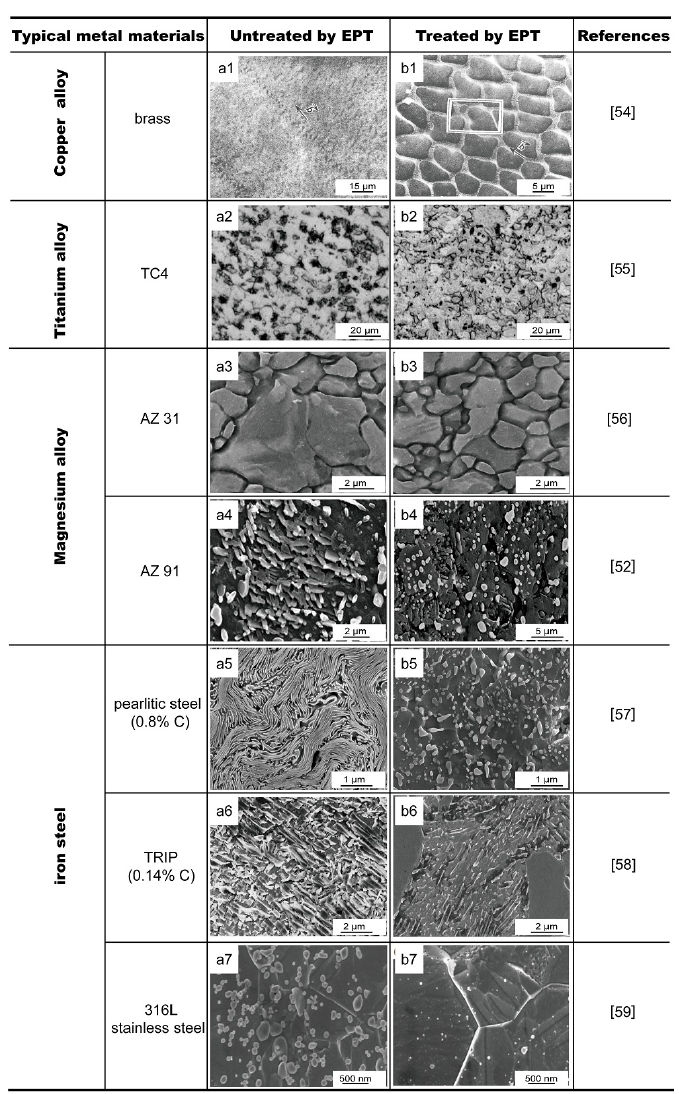
Figure 1. The microstructure of different alloys before treatment ( a1 – a7 ) and after electropulsing treatment (EPT) treatment ( b1 – b7 ).